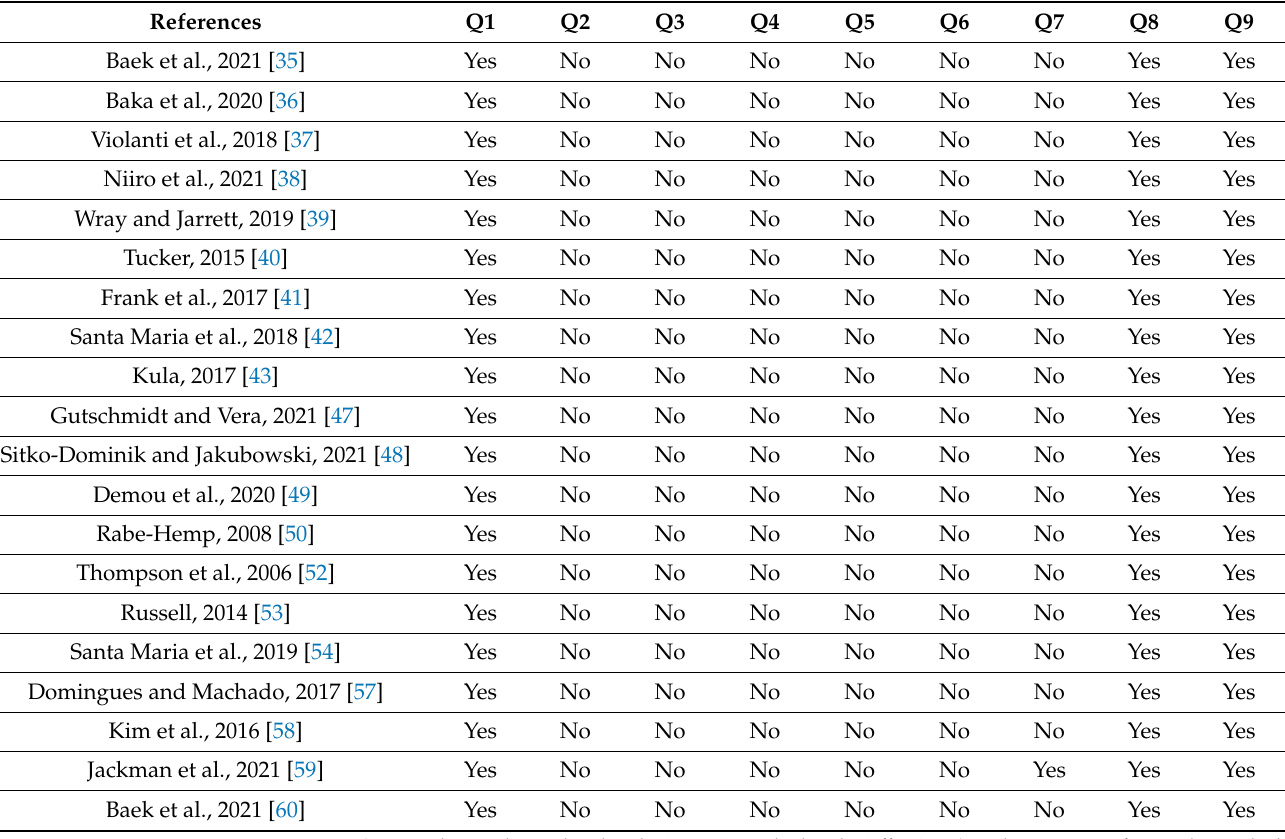
Table A1. Checklist to assess the quality of the study included in the narrative